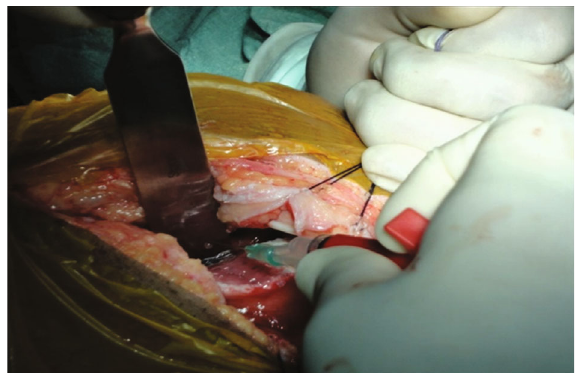
Figure 2: Intraoperative image showing chondrocyte implantation into the